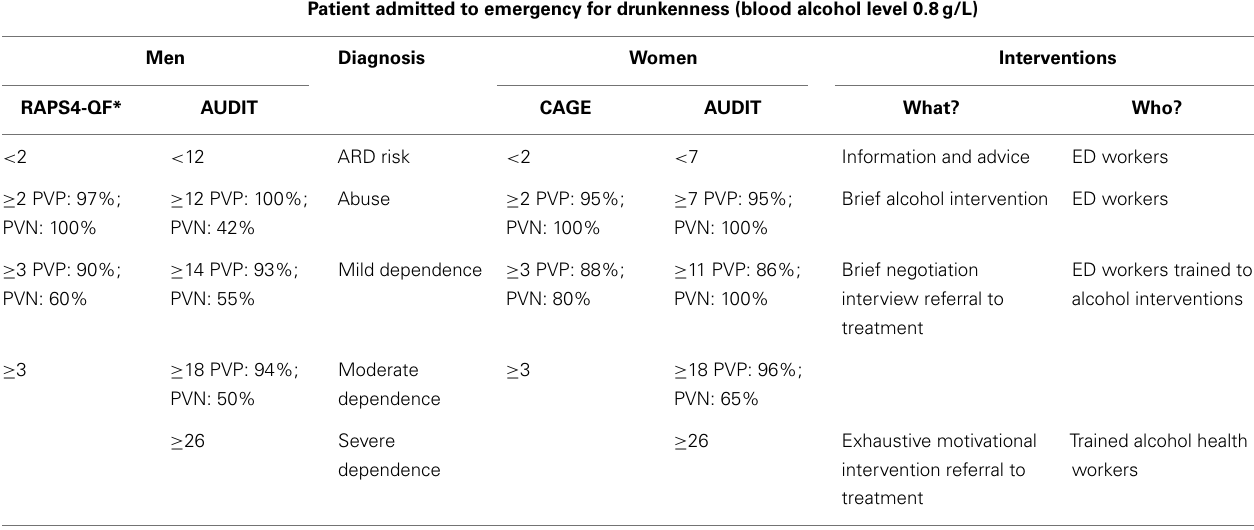
Table 2 | Proposal for the choice of interventions based on results of RAPS-QF,AUDIT, or CAGE . Patient admitted to emergency for drunkenness (blood alcohol level